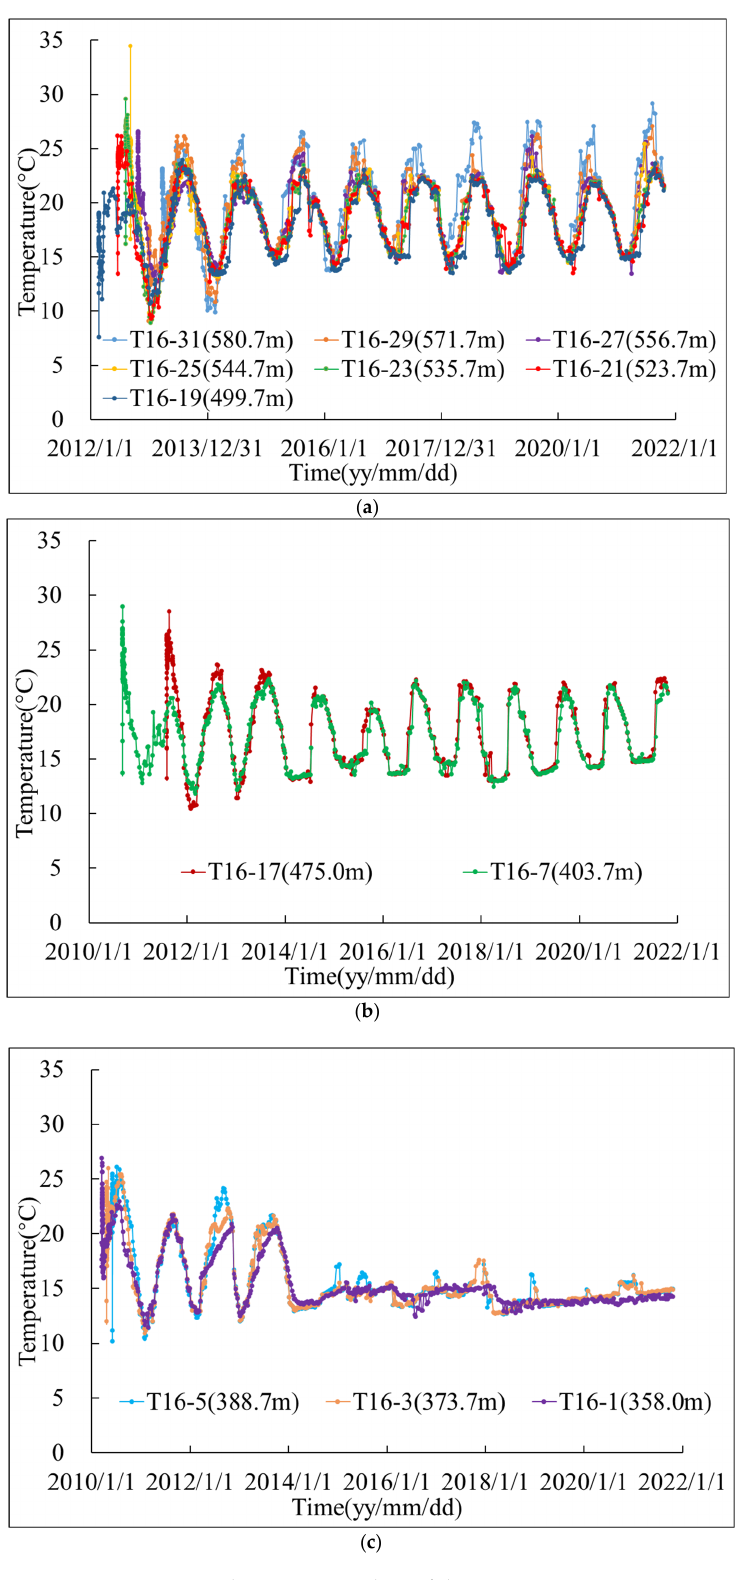
Figure 3. Temperature change process line of thermometer measuring points on the upstream surface of cantilever No. 16 dam section. ( a ) Measuring points above 500 m elevation; ( b ) Measuring points at 400~500 m elevation; ( c ) Measuring points below 400 m elevation.